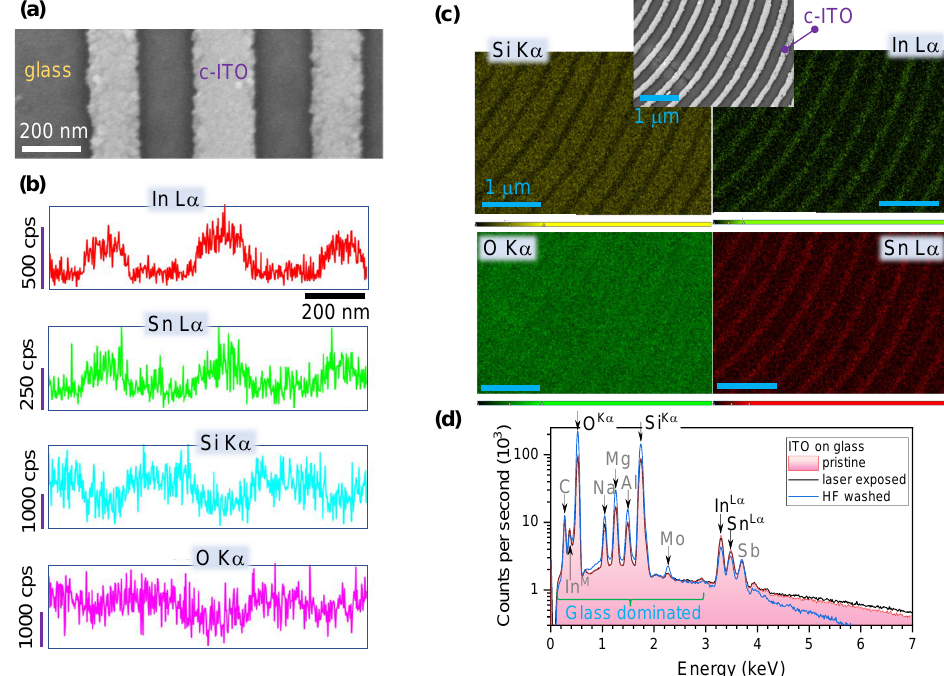
Figure 6. X-ray energy dispersion spectroscopy (EDS) analysis of c-ITO structure. ( a ) SEM image of c-ITO line structure after laser exposure and development. ( b ) Distribution of Si ( K α = 1.739 keV), O ( K α = 0.525 keV), In, Sn according their characteristic lines; 200 nm scale bar is same for all elemental maps. ( c ) Compositional maps of the four elements on the surface of sample. Inset shows SEM image of the mapped surface; all same 1 µ m scale bar. ( d ) The EDS spectra of pristine, laser irradiated and HF-developed ITO